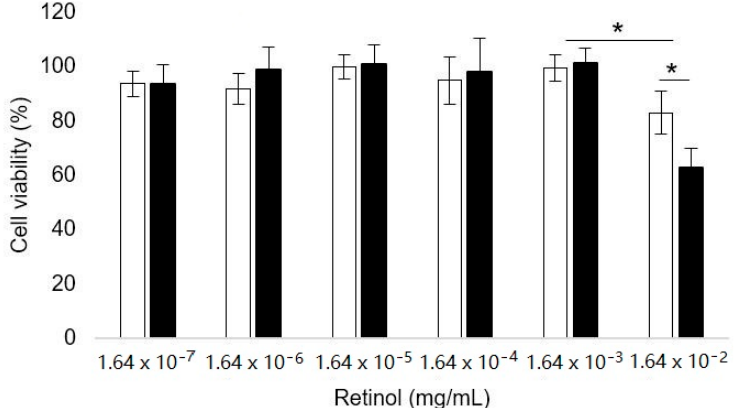
Figure 10. Cell viability of human keratinocytes (HaCaT) exposed to increasing concentrations of blank nanocarriers (open bars) and retinol-loaded nanocarriers (filled bars). Mean ± SD, n = 6. * p < 0.05.